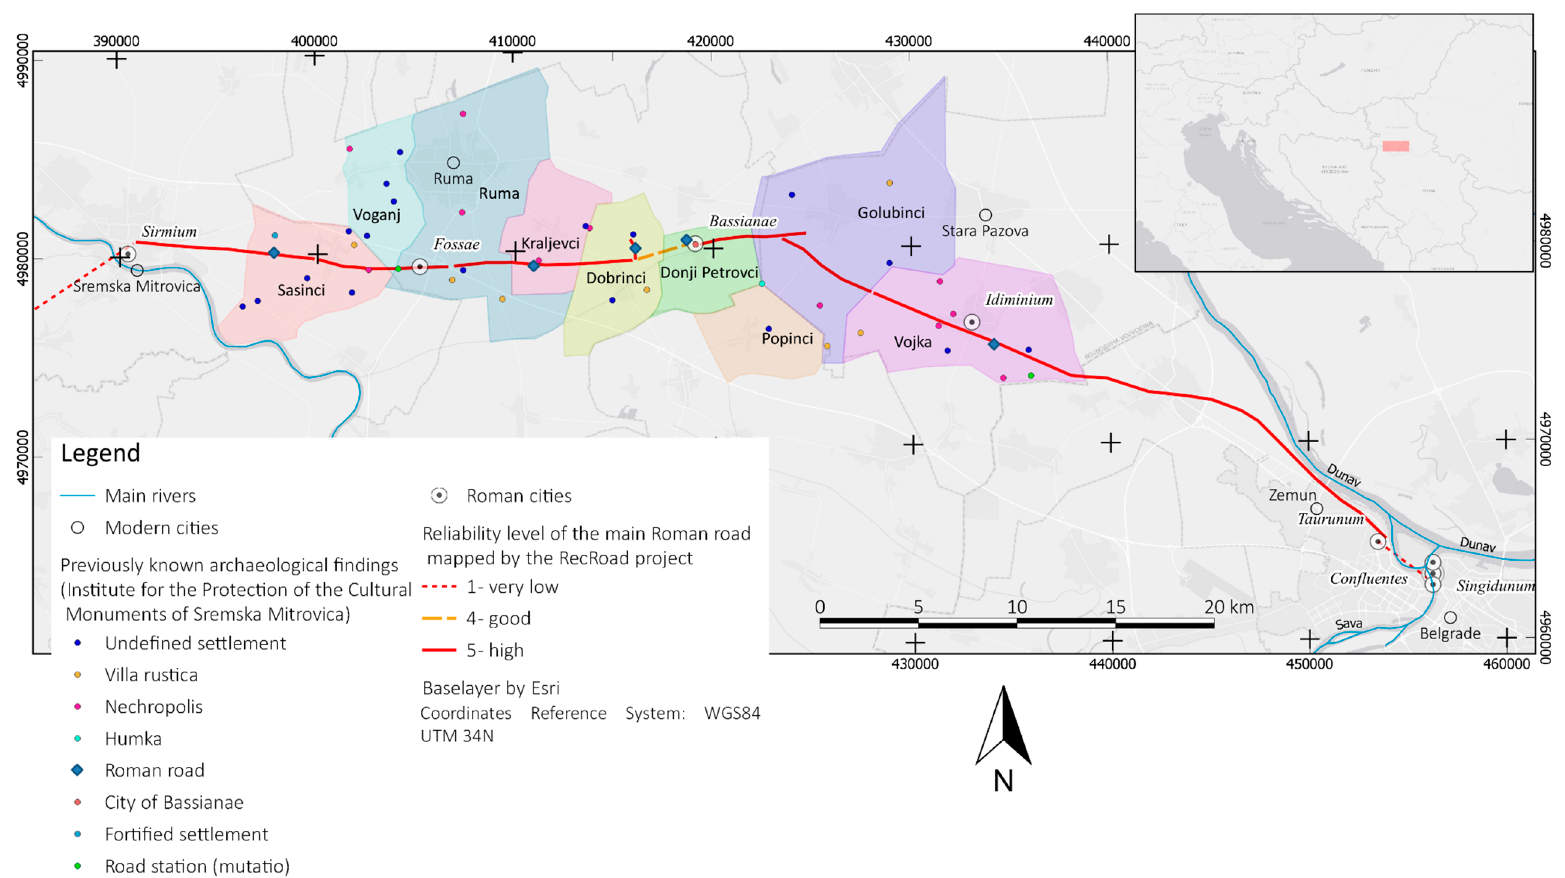
Figure 1. Map of the area of interest in the presented research. The five blue squares identify the remains of the Roman road already known before the beginning of the RecRoad project (courtesy of the Institute for the Protection of the Cultural Monuments of Sremska Mitrovica).